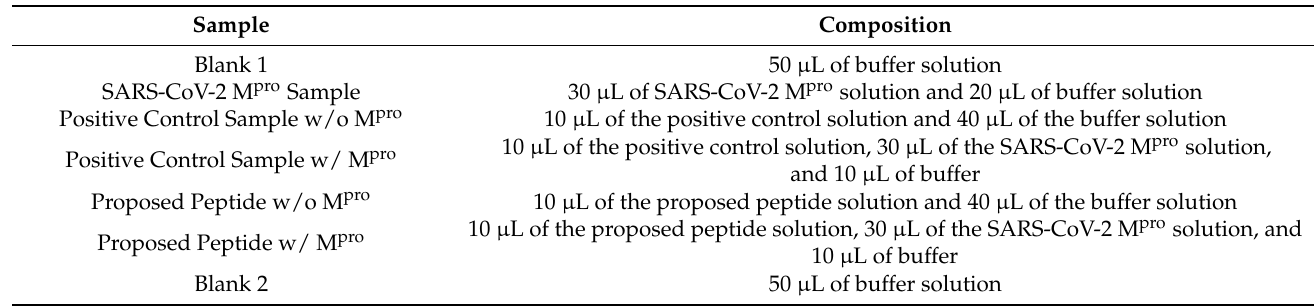
Table 1. Sample Compositions for Peptide Cleavage